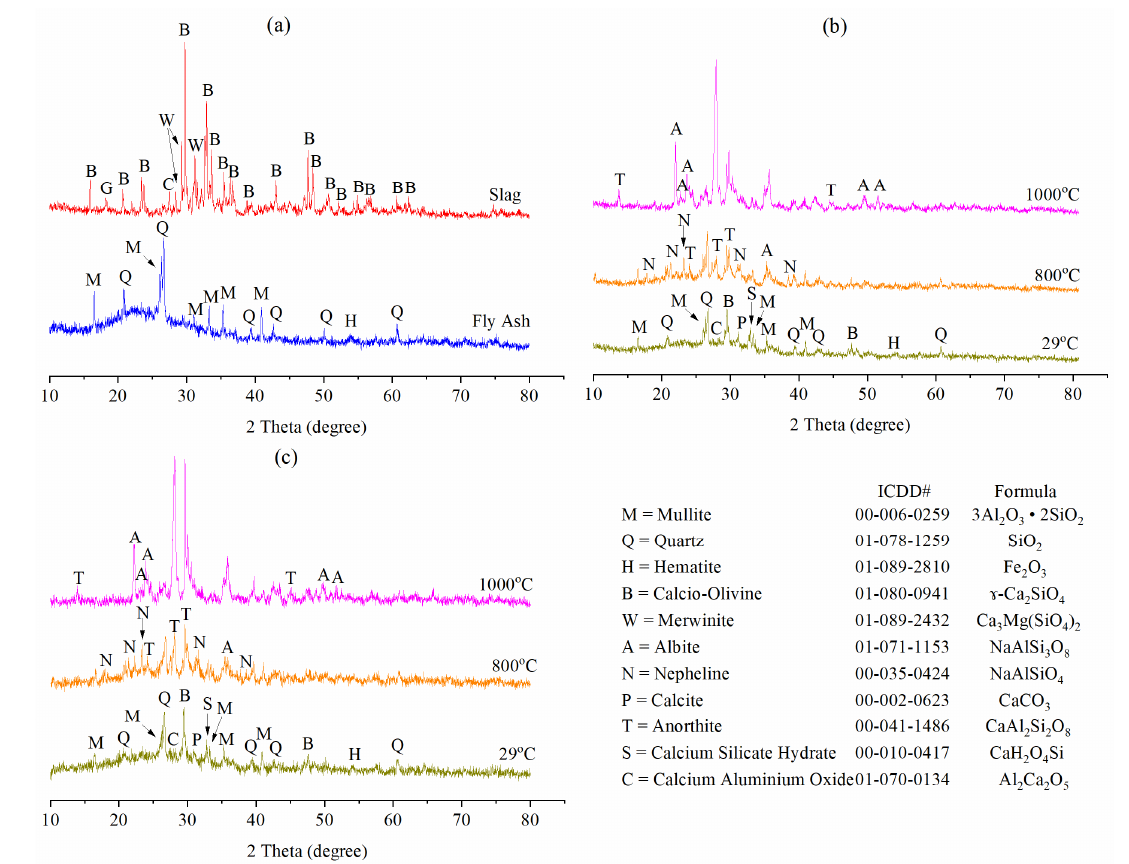
Figure 12. Phase patterns of ( a ) fly ash and slag, unexposed and temperature-exposed ( b ) G-0 and ( c ) G-2.